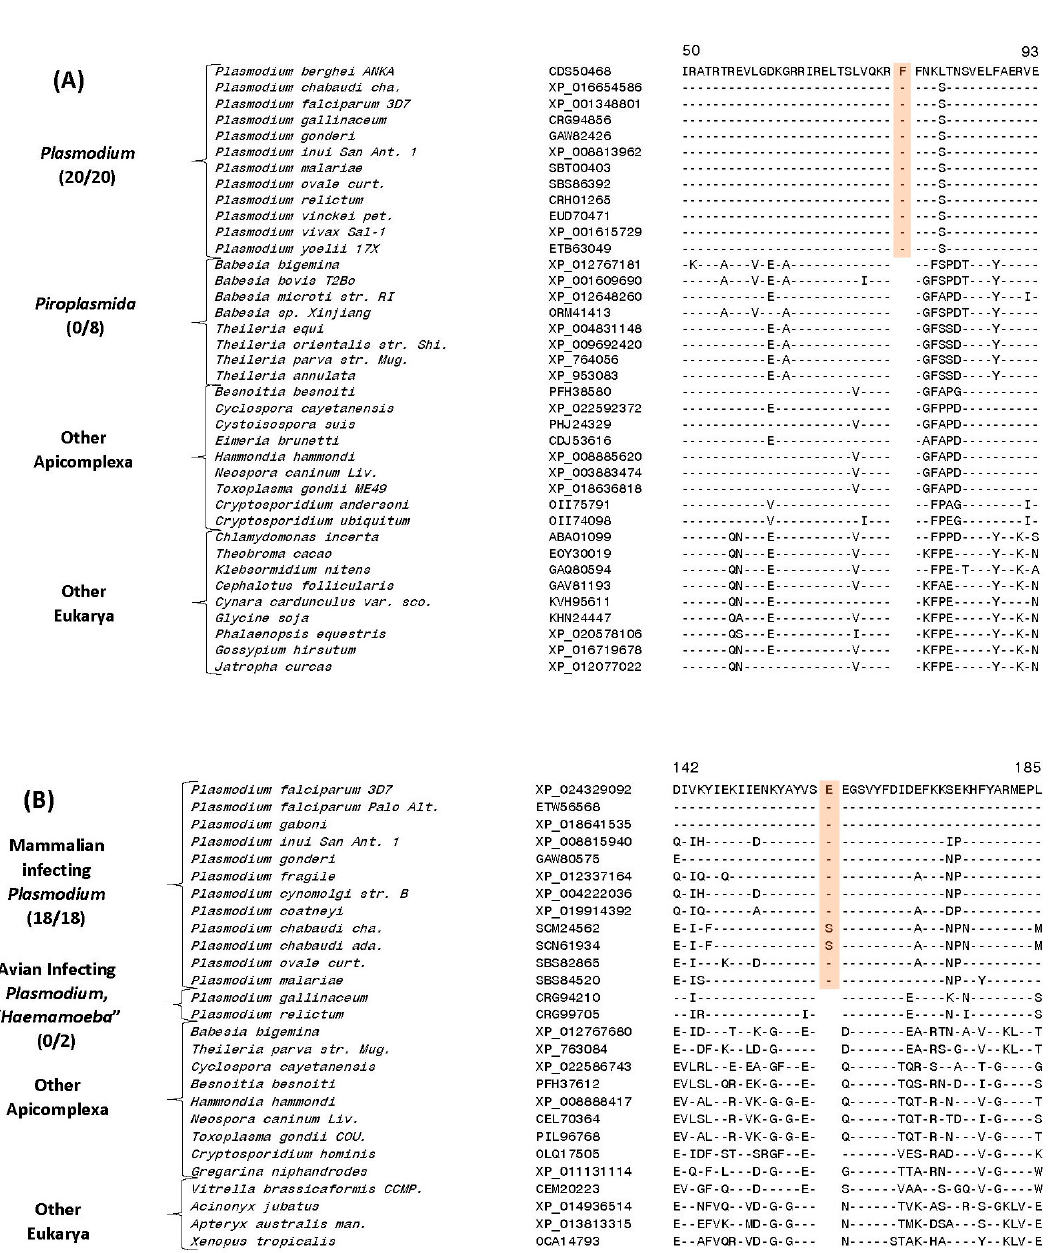
Figure 4. Sequence alignments of conserved signature indels specific for the genus Plasmodium and one that is exclusively found in the mammalian-infecting species. ( A ) Partial sequence alignment of the 40S ribosomal protein S3 showing a 1-aa insertion in a conserved region that is uniquely found in all available Plasmodium homologs. Sequence information for 22 other CSI in other proteins that are also specific for the genus Plasmodium is shown in Figures S17–S38 and their summary is provided in Table 2. ( B ) Partial sequence alignment of the protein cysteine-tRNA ligase showing a 1-aa insertion that is uniquely shared by all other Plasmodium homologs, but lacking in the avian-infecting species (subgenus Haemamoeba ) as well as other eukaryotic organisms.